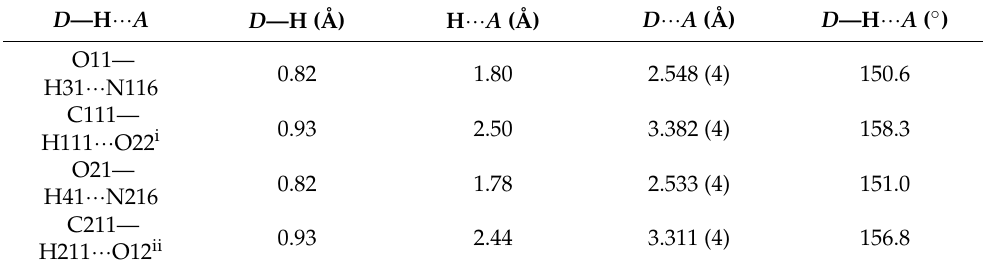
hydrogen bond. The same OH proton signal was moved to 17.76 ppm in CDCl 3 solvent. The explanation of this phenomenon is the ability to form a pseudo-ring by molecule 5b , stabilized by intramolecular hydrogen bond in the DMSO or CDCl 3 solvent (see Scheme 2, Figure 5). The structure of compound 5b confirmed by X-ray structural analysis showed strong intramolecular N ··· HO-N hydrogen bonds, which are listed in Table 1. Selected bond lengths (Å) and angles ( ◦ ) for 5b are collected in Table S3 from Supplementary Materials. Table 1. Hydrogen bonds for 5b .